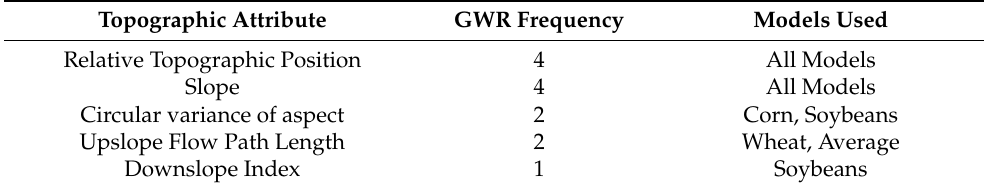
Table 4. Frequency of each topographic attribute included in GWR models. There was a total of 4 models one for each crop type and the average of all crop